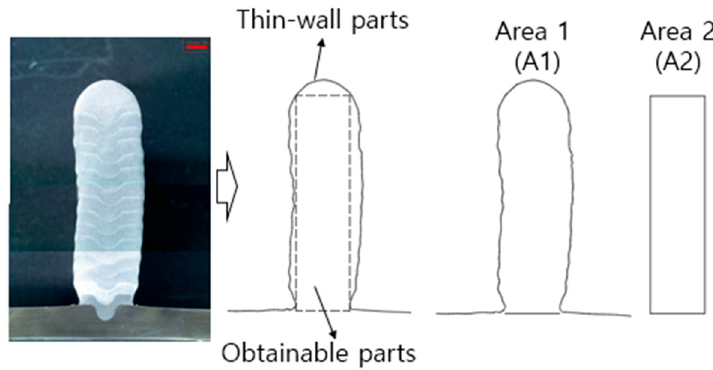
Figure 9. Determining the effective area of thin-wall parts for efficiency calculation.